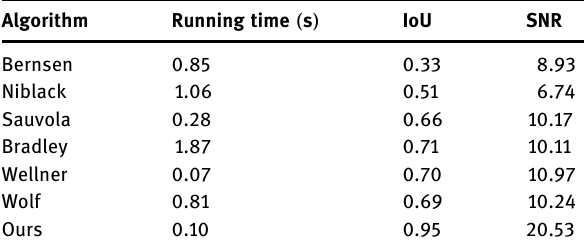
Table 1: Comparison of results of various algorithms Algorithm